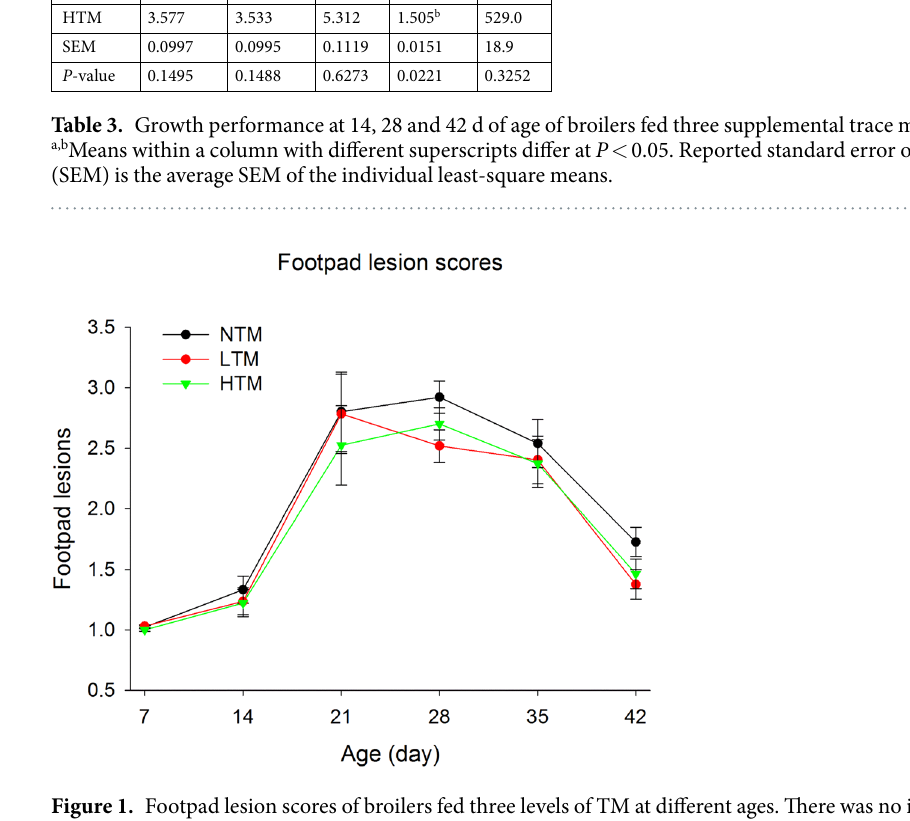
Figure 1. Footpad lesion scores of broilers fed three levels of TM at different ages. There was no interaction between treatments and